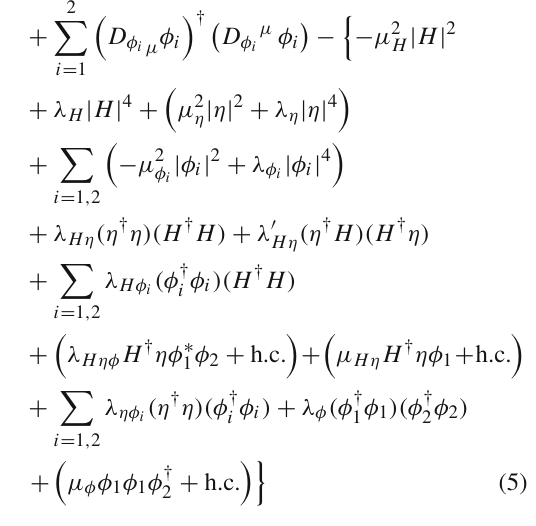
Table 2 Scalar content of the minimal model